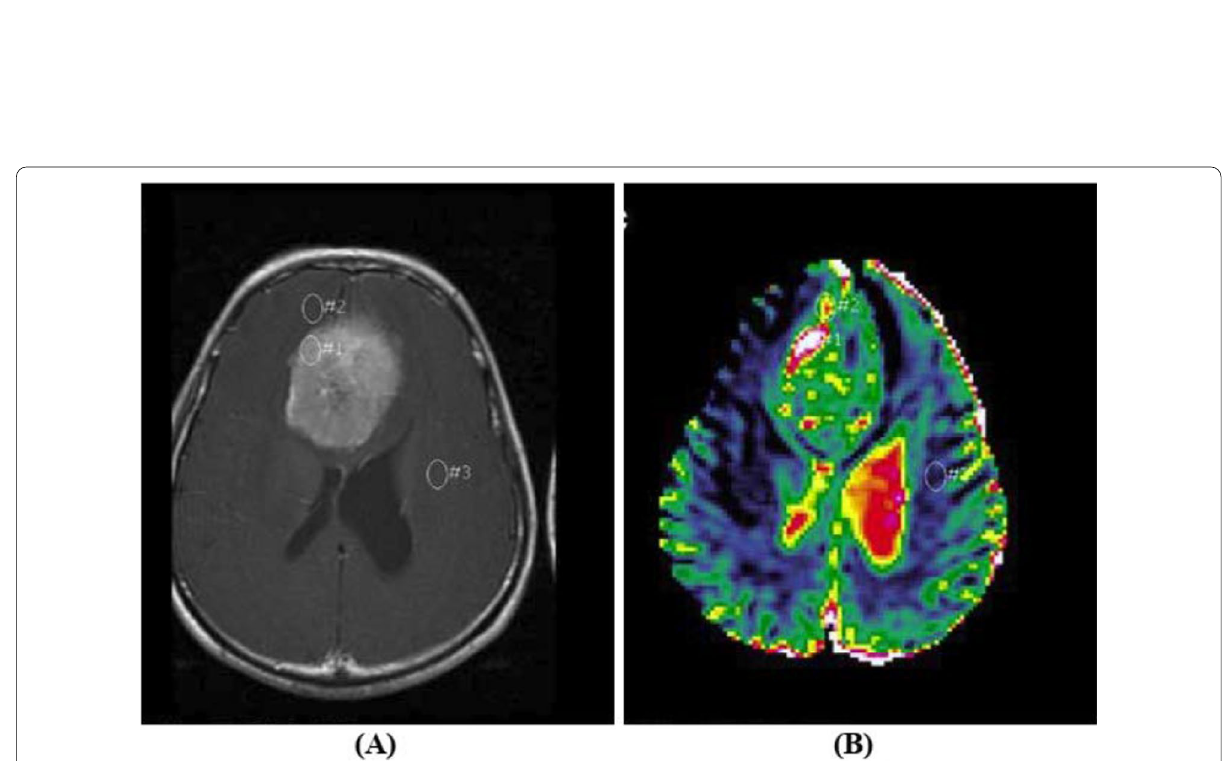
Fig. 7 MRI of intermediately vascular meningioma: A Axial T1 post contrast MRI showing intensely enhancing falcine meningioma. B ASL perfusion showing iso perfusion of the lesion with nCBF of 1.6 ml/100gm/min, proved surgically to have intermediate